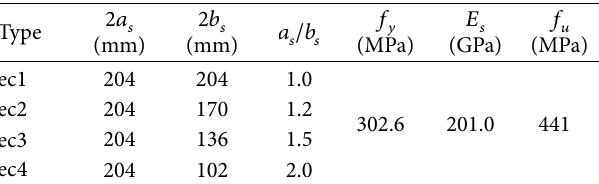
Table 2: Details of elliptical steel